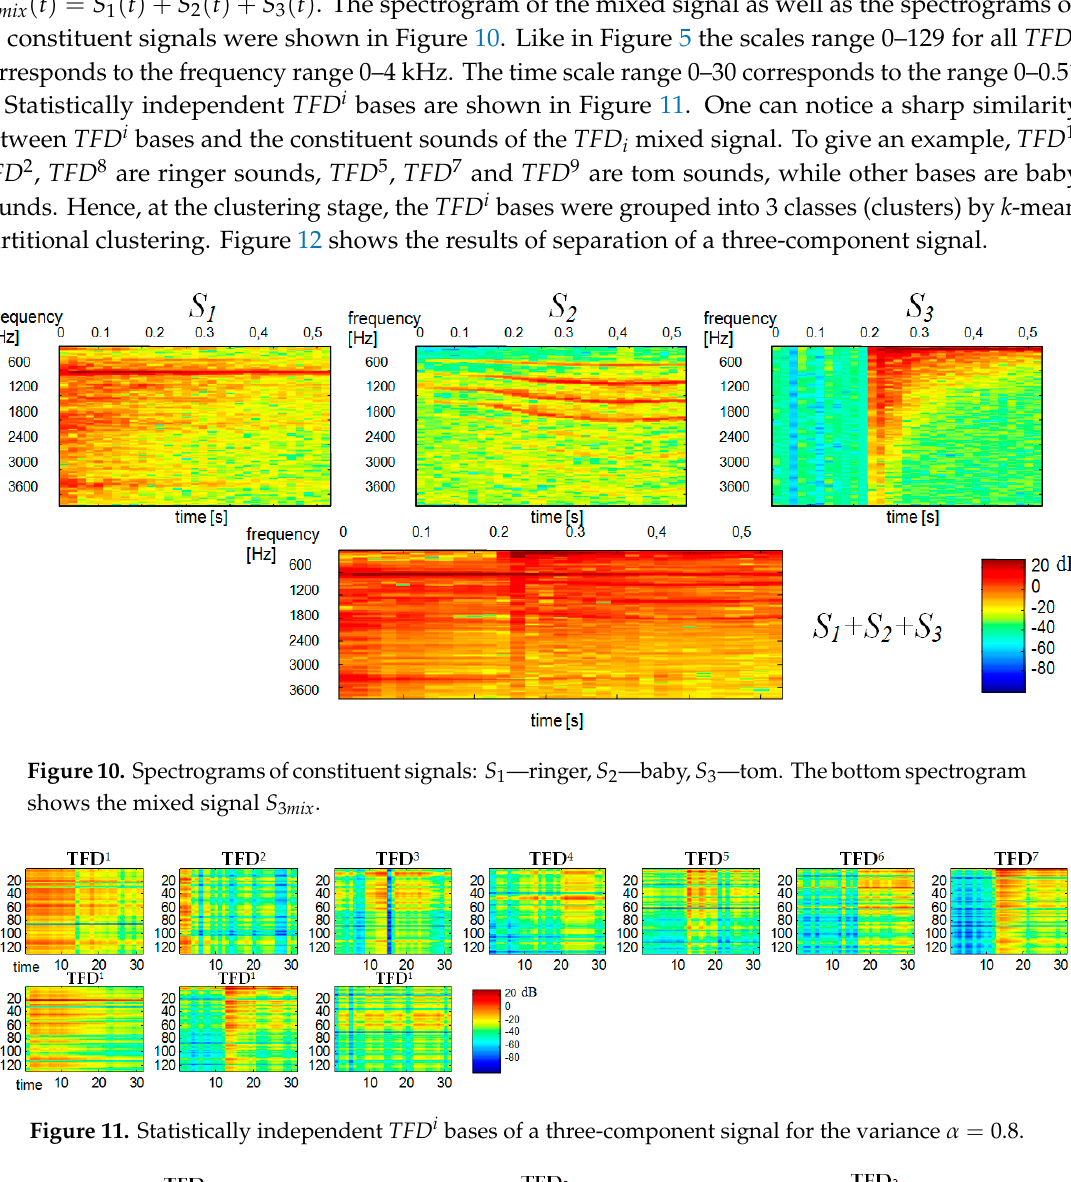
Figure 9. Reconstructed spectrograms (spectra) of 𝑇𝐹𝐷 (cid:2869) and 𝑇𝐹𝐷 (cid:2870) components obtained by k-mean partitional clustering and the 𝛽 distance of Gaussian distribution. 𝑇𝐹𝐷 (cid:2869) —ringer, 𝑇𝐹𝐷 (cid:2870) —baby. The results were obtained for the variances a ) α = 0.7 and b ) α = 0.8 , respectively, and the signal duration of 1.2 s.